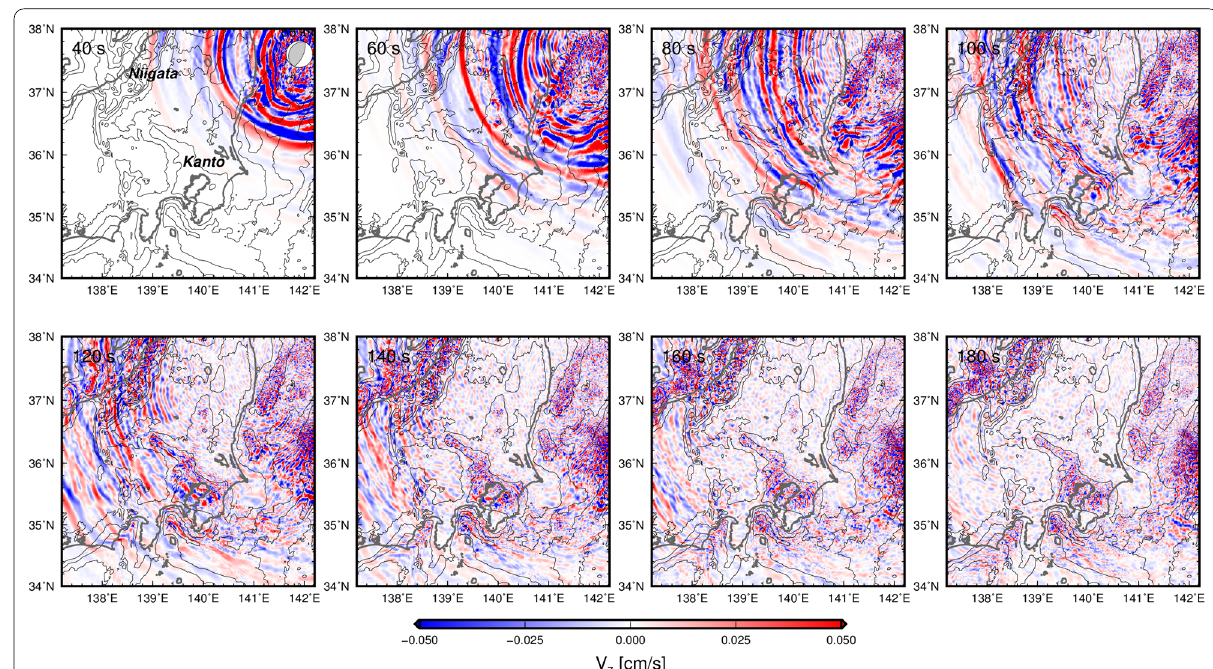
Fig. 8 Snapshots of simulated vertical velocity wavefield for Event A. The numbers at the left-top corner are lapse times from the earthquake origin. The contour lines are the JIVSM bedrock depths at 2 km intervals